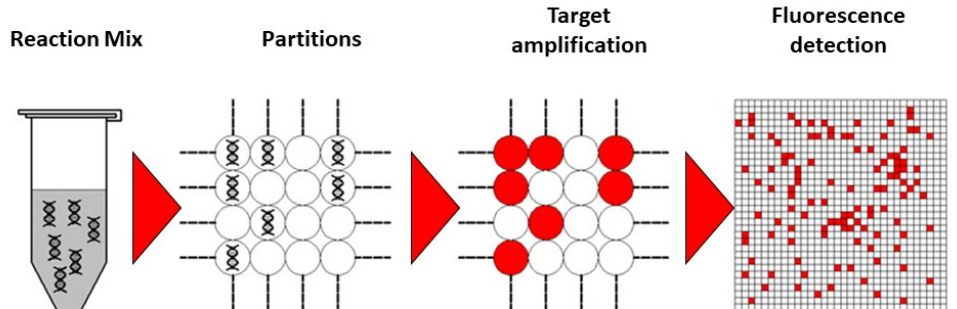
Figure 2. dPCR workflow. The mix of reaction contains the master mix, the assay, and the sample. It is partitioned in thousands of micro-reactions. Micro-reactions are thermal cycled in order to obtain the target amplification. This step is followed by the fluorescence detection and the data analysis. A micro-reaction emitting fluorescence is considered “positive”.